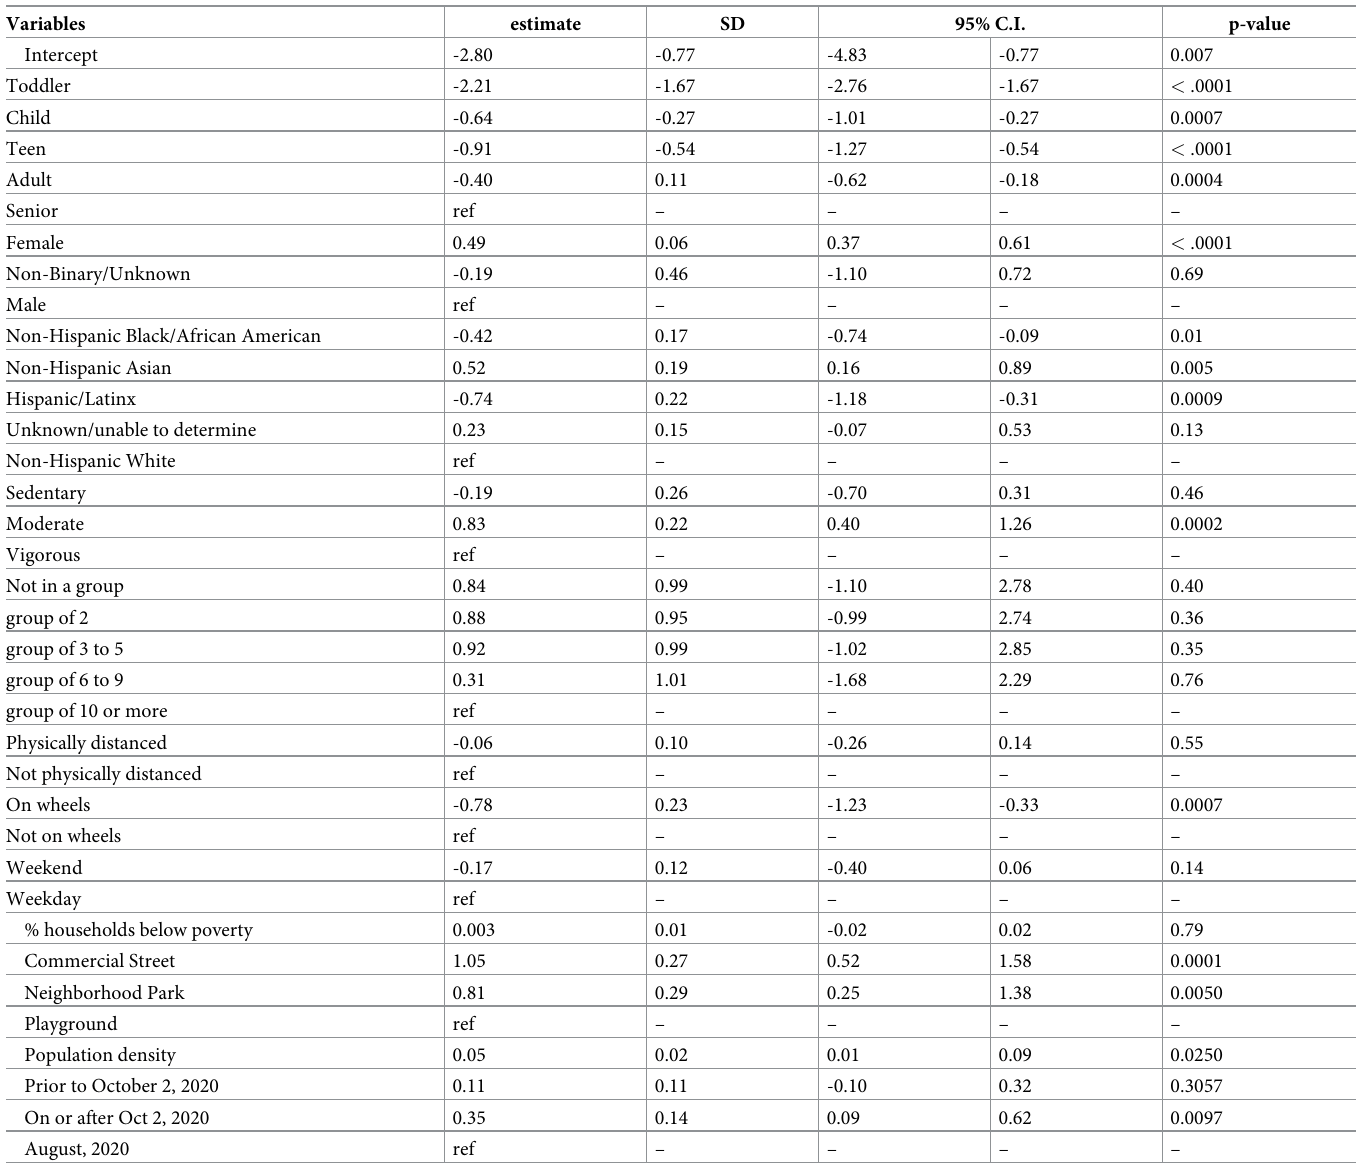
Table 2. Model of mask use over